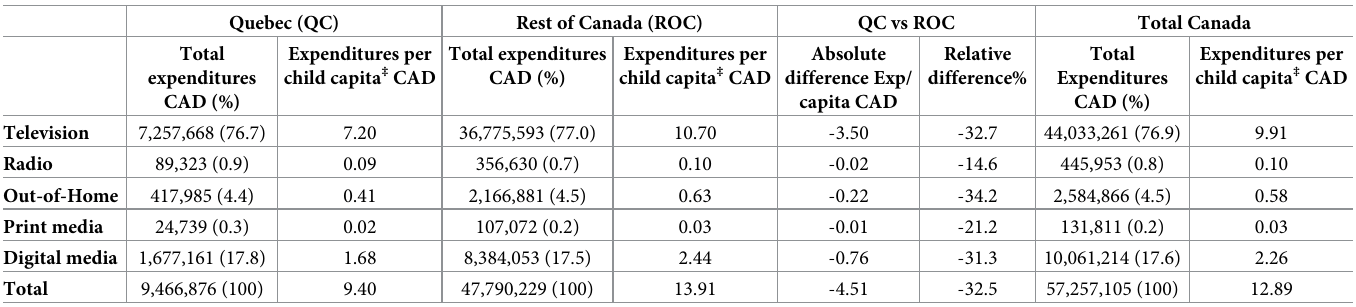
Table 3. Advertising expenditures on child-targeted products † in 2019, by media and geographic area. Quebec (QC) Rest of Canada (ROC) QC vs